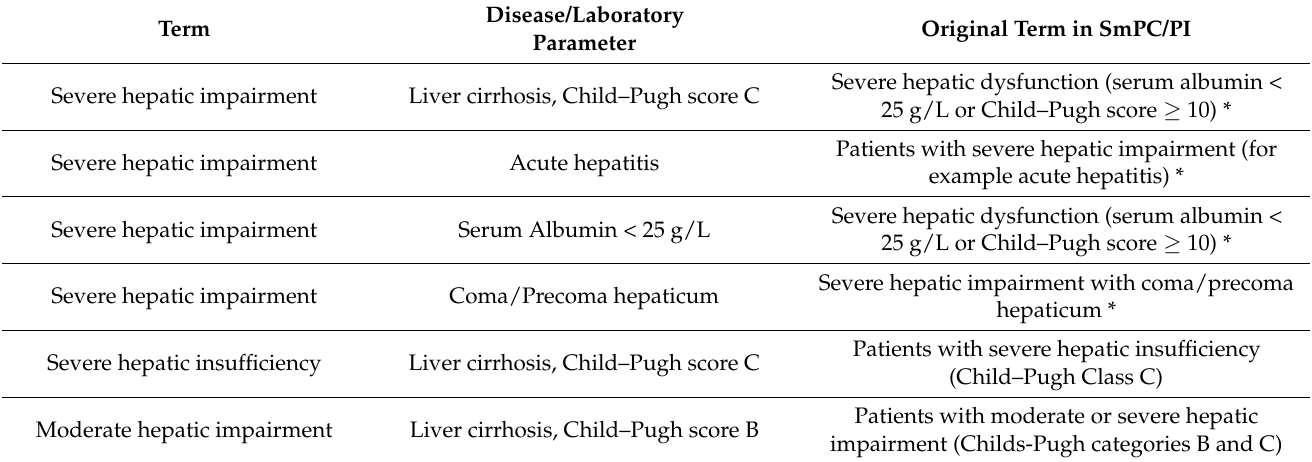
Table 4. Combinations of ambiguous and more clearly defined